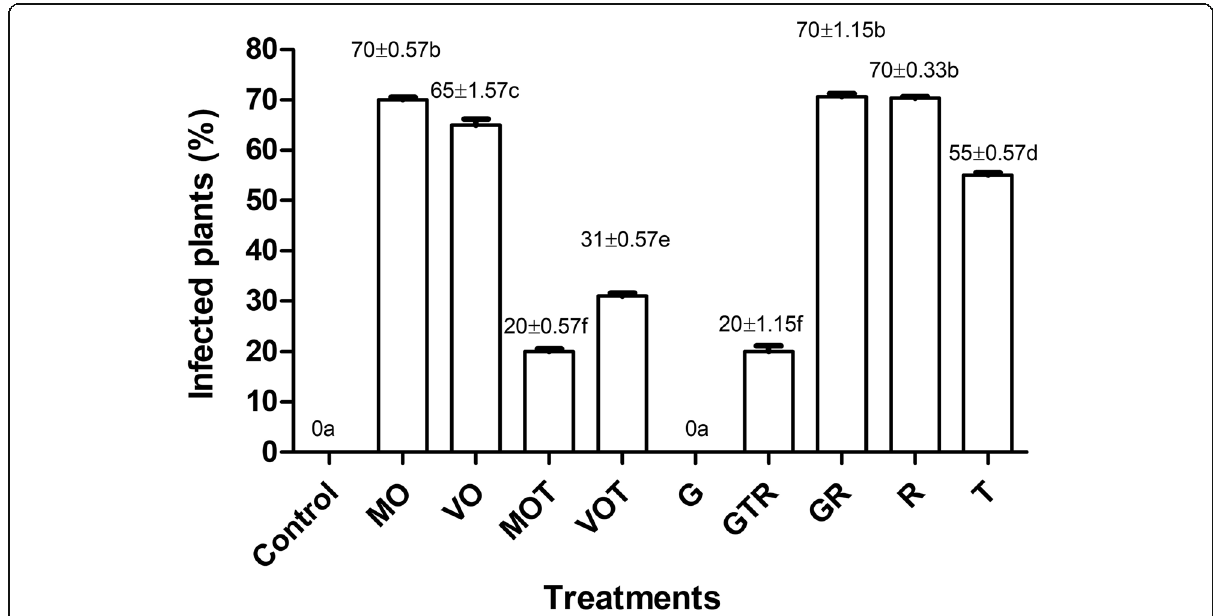
Fig. 3 Corn seedlings infected with R. solani . MO, mineral oil without Trichoderma asperellum or Rhizoctonia solani; VO, vegetable oil without T. asperellum or R. solani ; MOT, mineral oil with T. asperellum ; VOT, vegetable oil with T. asperellum ; G, granular formulation without T. asperellum or R. solani ; GTR, granular formulation with T. asperellum ; GR, granular formulation without T. asperellum ; R, R. solani without treatment; T T. asperellum without formulation. Letters indicate statistical differences